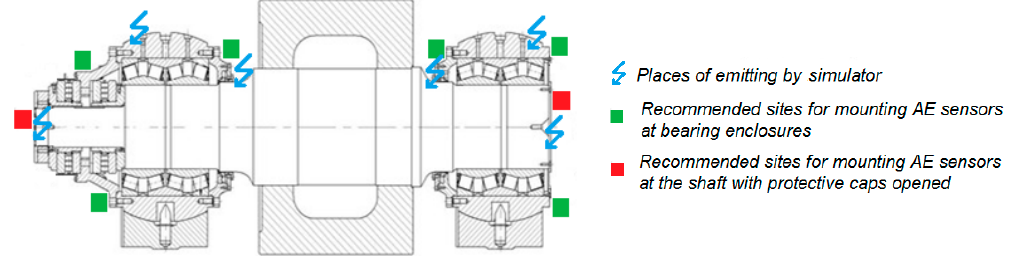
Figure 18. Scheme of the roller bearing with the protective caps removed. The points of emitting by simulator and the recommended positions for the sensors mounting.